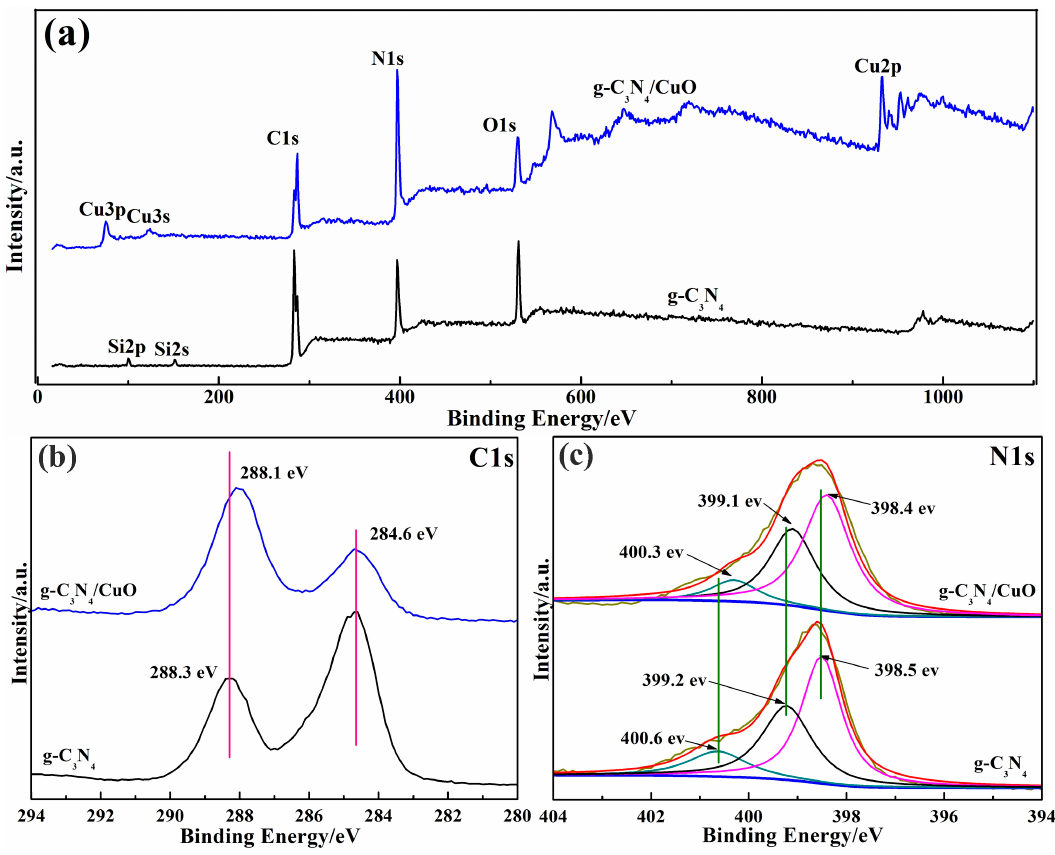
Figure 4. X-ray photoelectron spectra (XPS) of g-C 3 N 4 and g-C 3 N 4 /20 wt % CuO nanocomposite: ( a ) full scan; ( b ) high resolution C1s; ( c ) high resolution N1s.